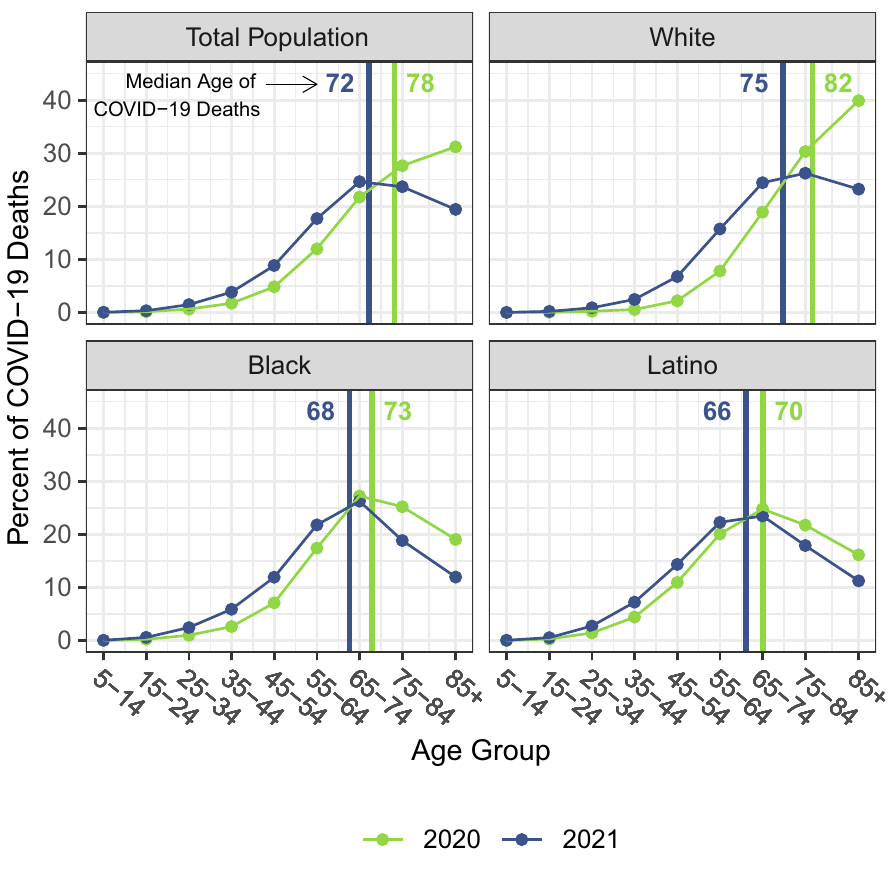
Fig 1. Percentage of COVID-19 deaths in each age group by race/ethnicity, 2020 and 2021. Vertical lines indicate the median age of COVID-19 deaths in each year. We estimate the median age of COVID-19 deaths in both years with the assumption that deaths occur uniformly within each age group. Data are from CDC WONDER (July 6, 2022, update). Deaths below age 5 are not shown because some counts are